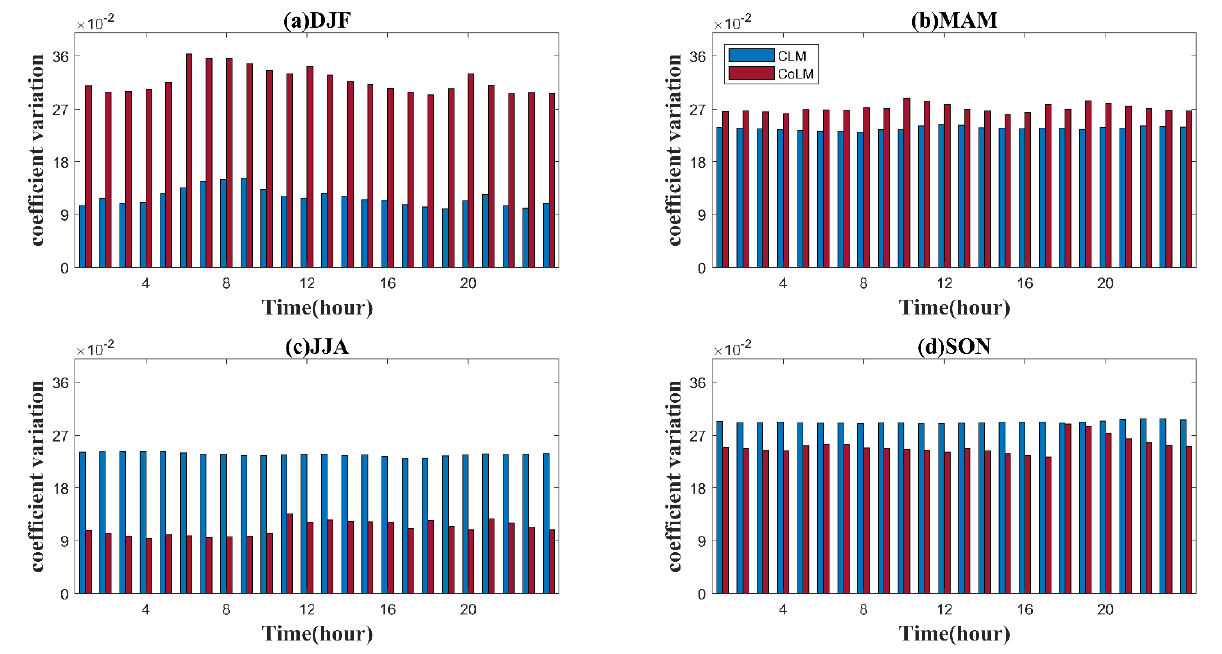
Figure 10. The shallowest layer’s coefficient of variation of diurnal simulations at the Tnc Fort Bayou site, with CLM5 simulations in blue bars and CoLM2014 simulations in red bars, for ( a – d ) winter, spring, summer, and autumn, respectively.